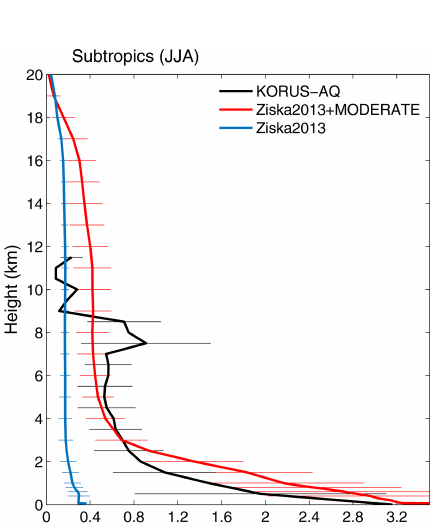
Figure 7. Same as Fig. 6 only during DJF.